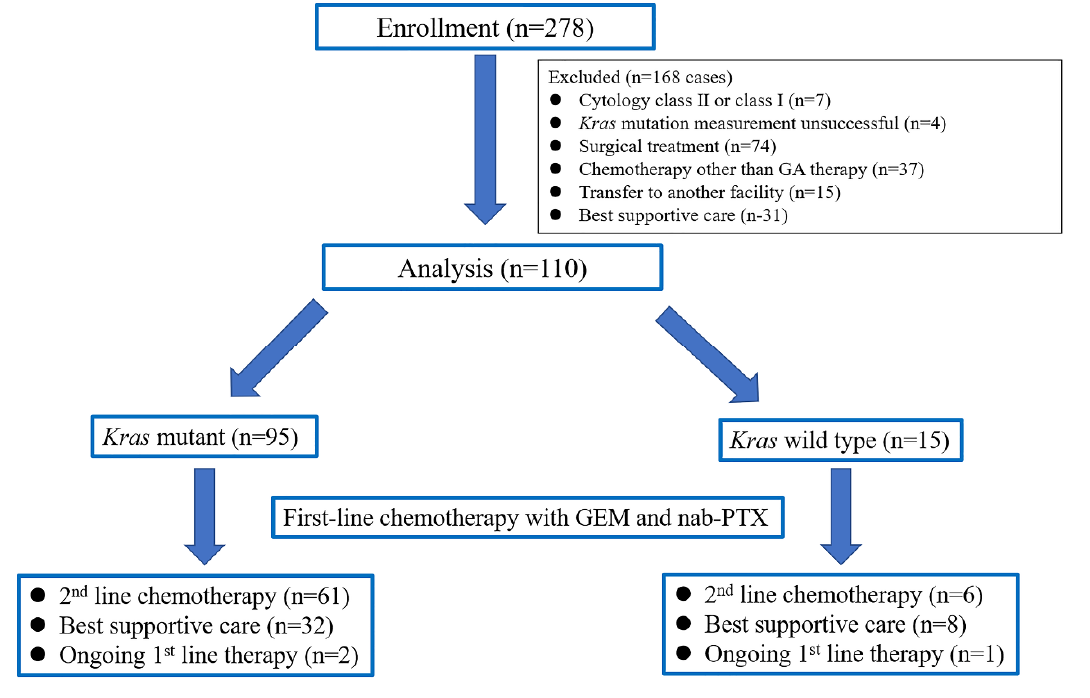
Figure 1. Study flow chart. Table 1. Clinical characteristics of study patients.